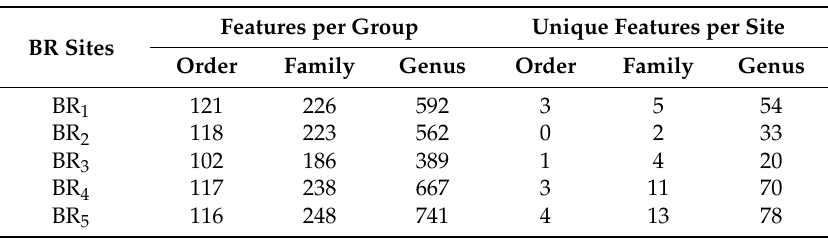
Table 5. Summary of site bacterial metagenomics